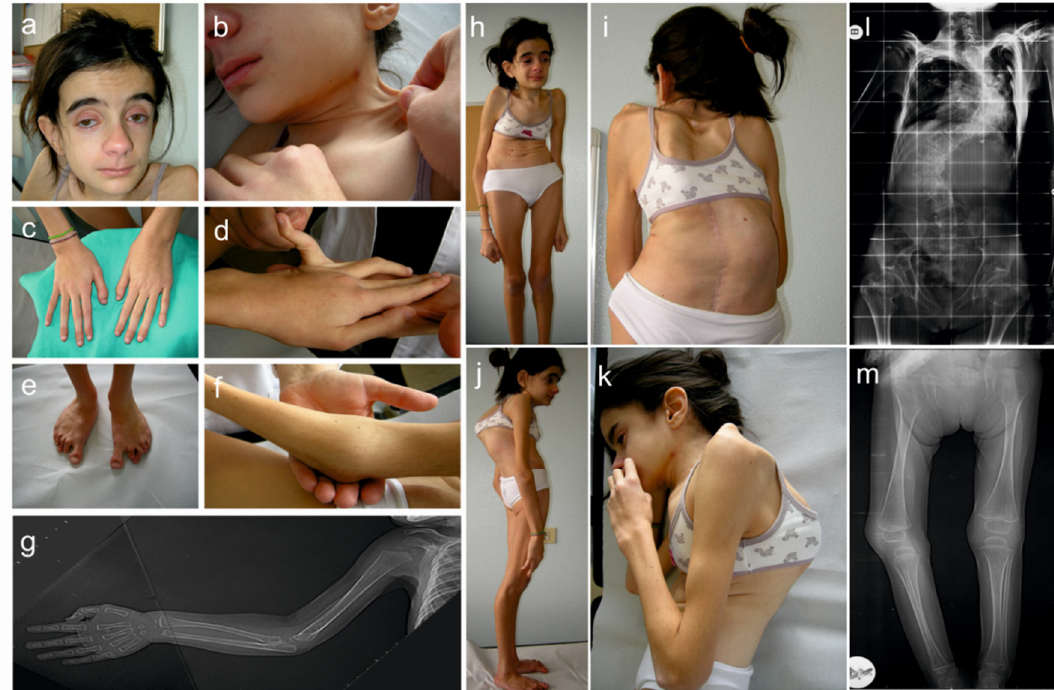
Figure 2. Clinical findings of the patient. Facial dysmorphism: enophthalmos, midface hypoplasia, prominent forehead, micrognathia, low-set ears, and short neck ( a ), skin hyperextensibility over the neck ( b ), long fingers with spatulate distal phalanges and clinodactyly of the fifth finger ( c ), joint laxity of the fifth finger ( d ), foot deformities: sandal gaps, severe pes planovalgus and clinodactyly of the toes ( e ), elbow deformity with reduction in the range of motion ( f ), radioulnar synostosis ( g ), severe kyphoscoliosis ( h – l ), pectus carinatum ( h ), muscle hypotonia ( h – k ), and metaphyseal flaring ( m ).